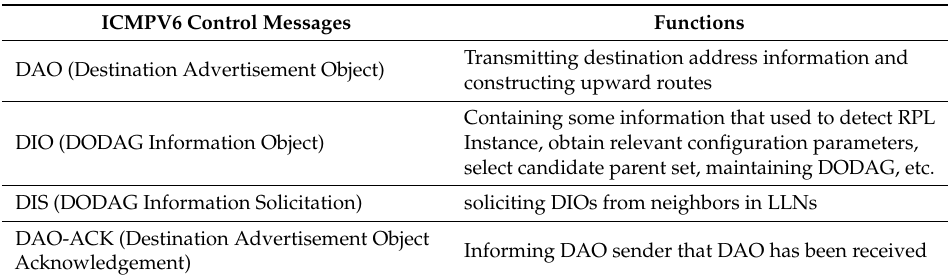
Table 1. ICMPV6 control messages used in